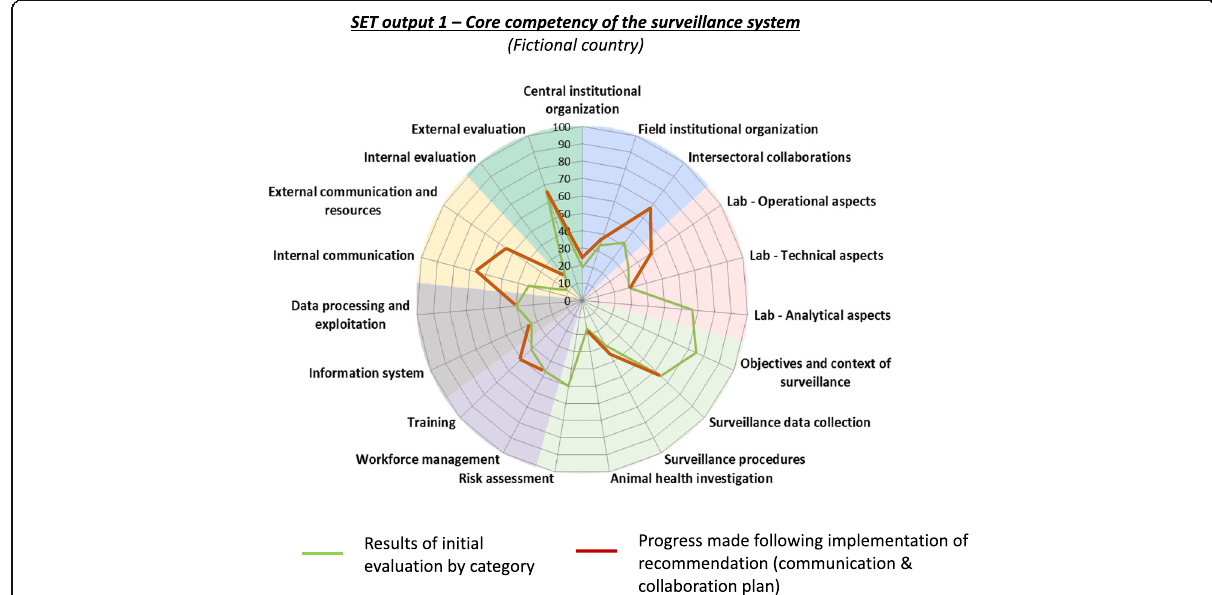
Fig. 1 Example of graphical output of the FAO Surveillance Evaluation Tool (SET) using figurative results of a fictive country. The spider graph shows results by SET category of a fictive country who has conducted two SET evaluations. Each of the 19 SET categories form an individual axis whose value varies from 0 to 100%. The green line shows results for the first SET evaluation and the red line shows results for the second SET evaluation conducted 3 – 5years after the initial evaluation. The closer either line is positioned to the outer border of the graph, the higher the capacity of the country in the respective category and vice-versa. The graphic shows the progress the country has made after implementing the recommendations of the first SET evaluation, particularly the development and implementation of a communication and inter-sectoral collaboration